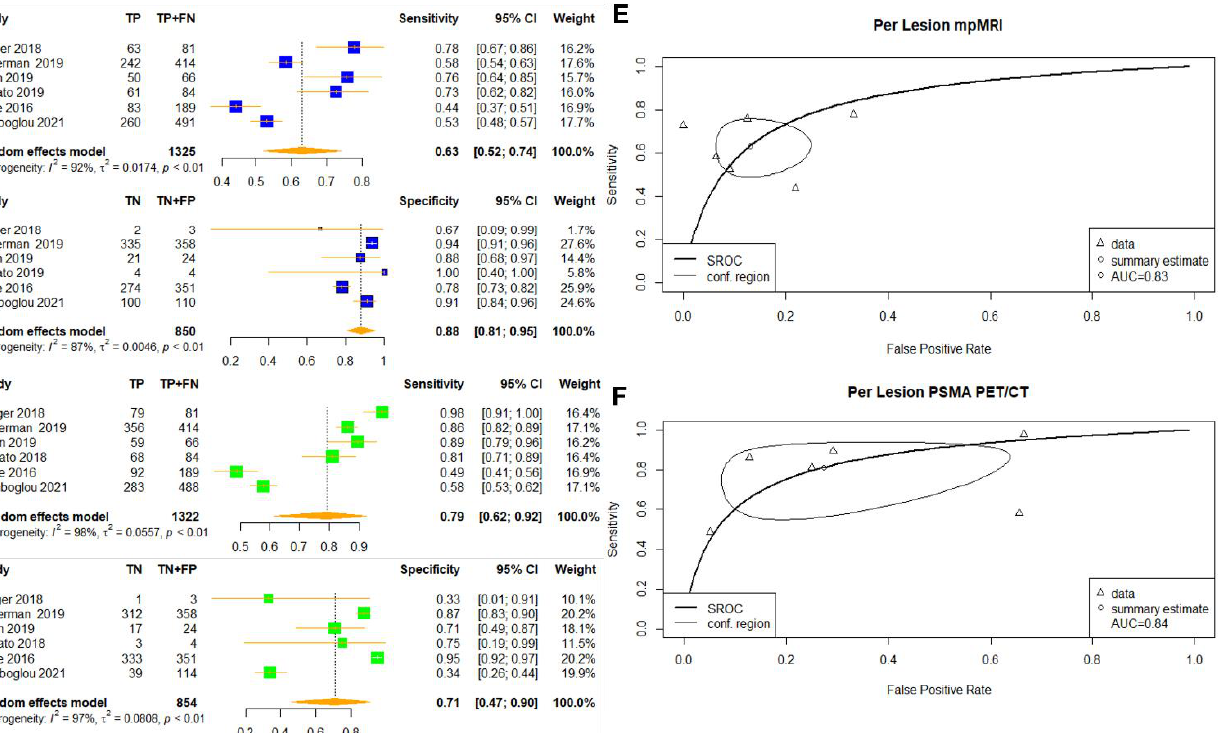
Figure 3. ( A – F ) Reported sensitivity and specificity values for both mpMRI and PSMA PET/CT with AUC values on SROC curves for per-lesion analysis. Forest plots for pooled sensitivities and specificities are displayed in bold and as diamonds in the graphs for mpMRI ( A , B ) and PSMA PET/CT ( C , D ). The SROC curves indicate the summary estimates in circles ( E for mpMRI; F , PSMA PET/CT). Triangles represent included study, with dotted lines representing the confidence interval and solid lines for the SROCs. AUC values are displayed in the legend. mpMRI — multiparametric magnetic-resonance imaging; PSMA PET/CT — prostate-specific membrane antigen positron-emission tomography/computed tomography; AUC — area under the curve; SROC — summary receiver operating characteristic.